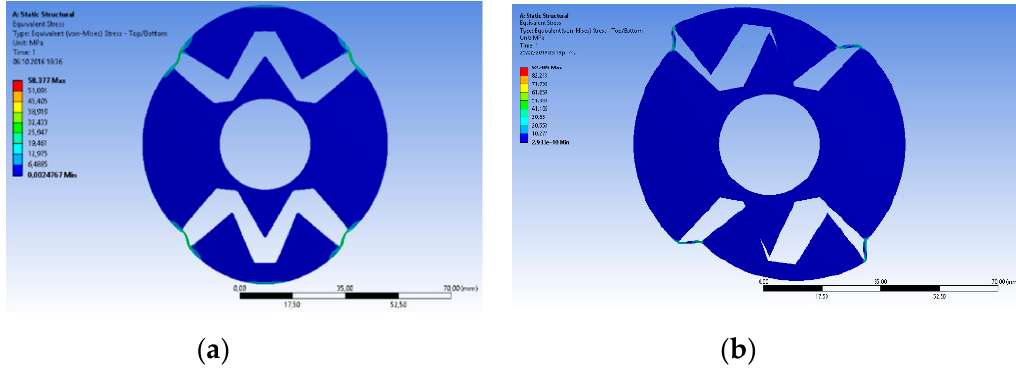
Figure 6. Results of the mechanical FEA: ( a ) with rotor speed n = 2.0 n n and shaft torque t = 0, ( b ) with rotor speed n = 1.0 n n and shaft torque t = 2 t n .